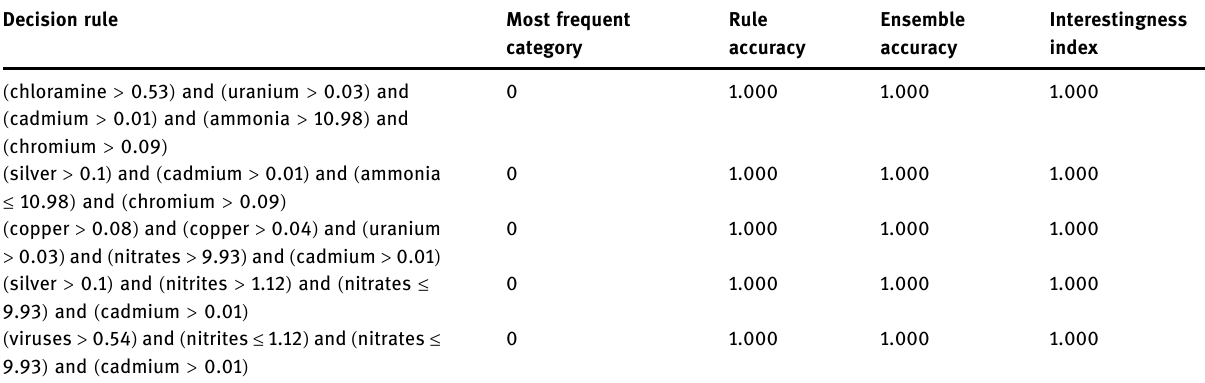
Table 2: Top decision rules for “ is safety ” Decision